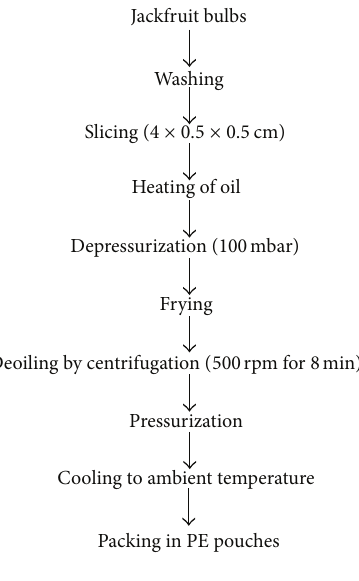
Figure 1: Vacuum frying process of jackfruit